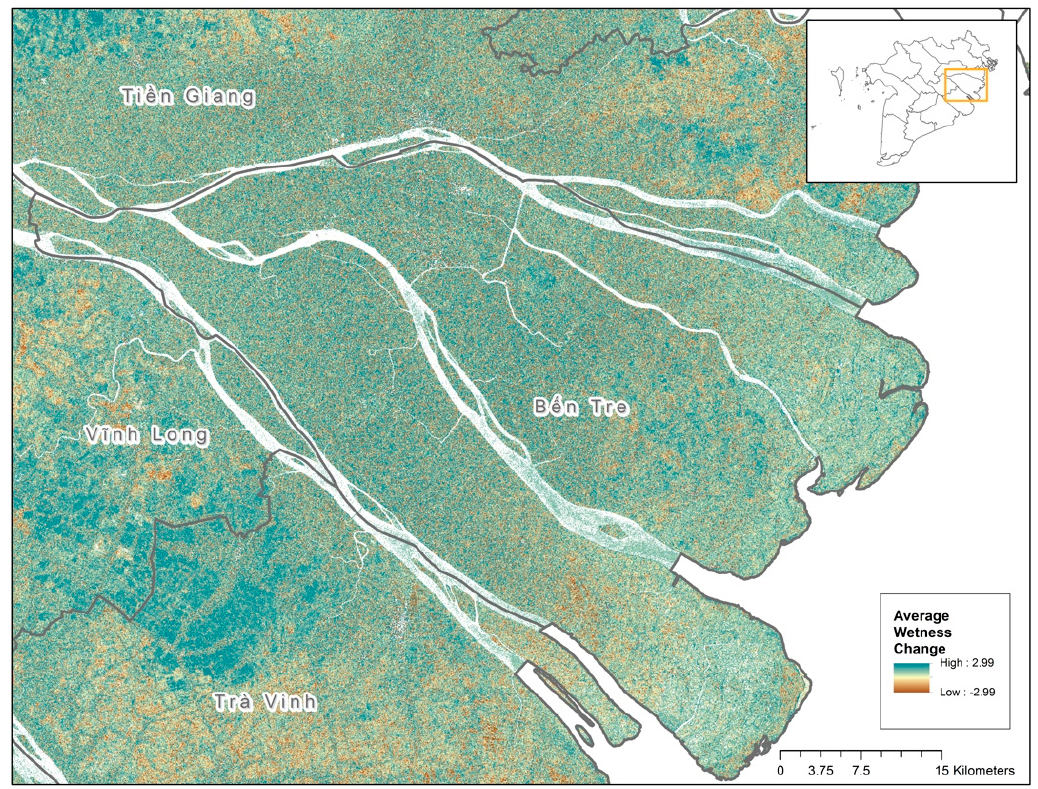
Figure 7. Coastal average WI change. The coastal pattern of higher WI averages shows an overall average trend toward flooding or a higher WI score. These results demonstrate that coastal provinces, such as Ben Tre, adopt AWD practices less often than the inland provinces.